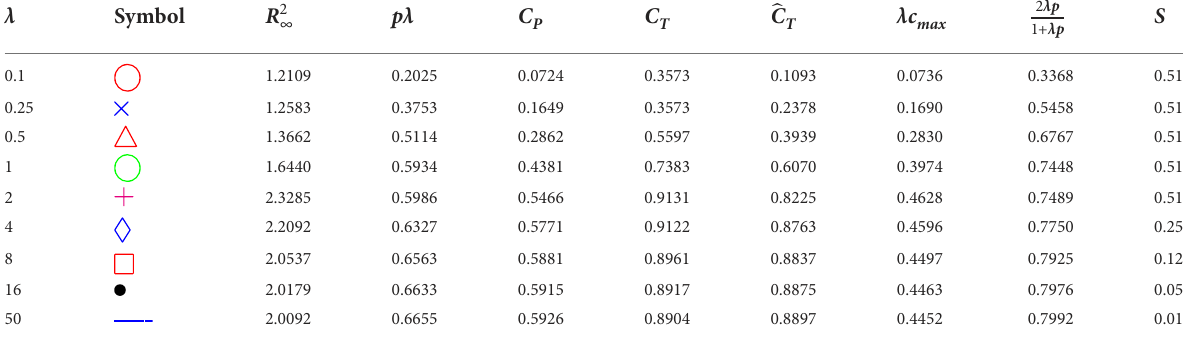
TABLE 1 PerformanceofOptimalRotorsandsymbolsforFigures